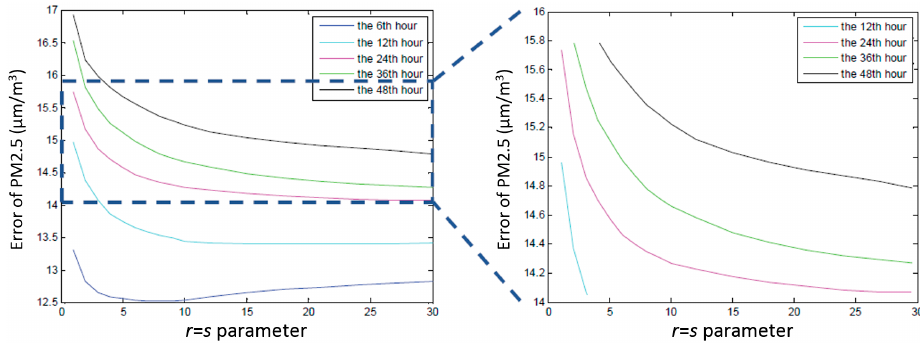
Figure 10. The impact on PM2.5 error of parameter r and s on the PM2.5 value forecast.